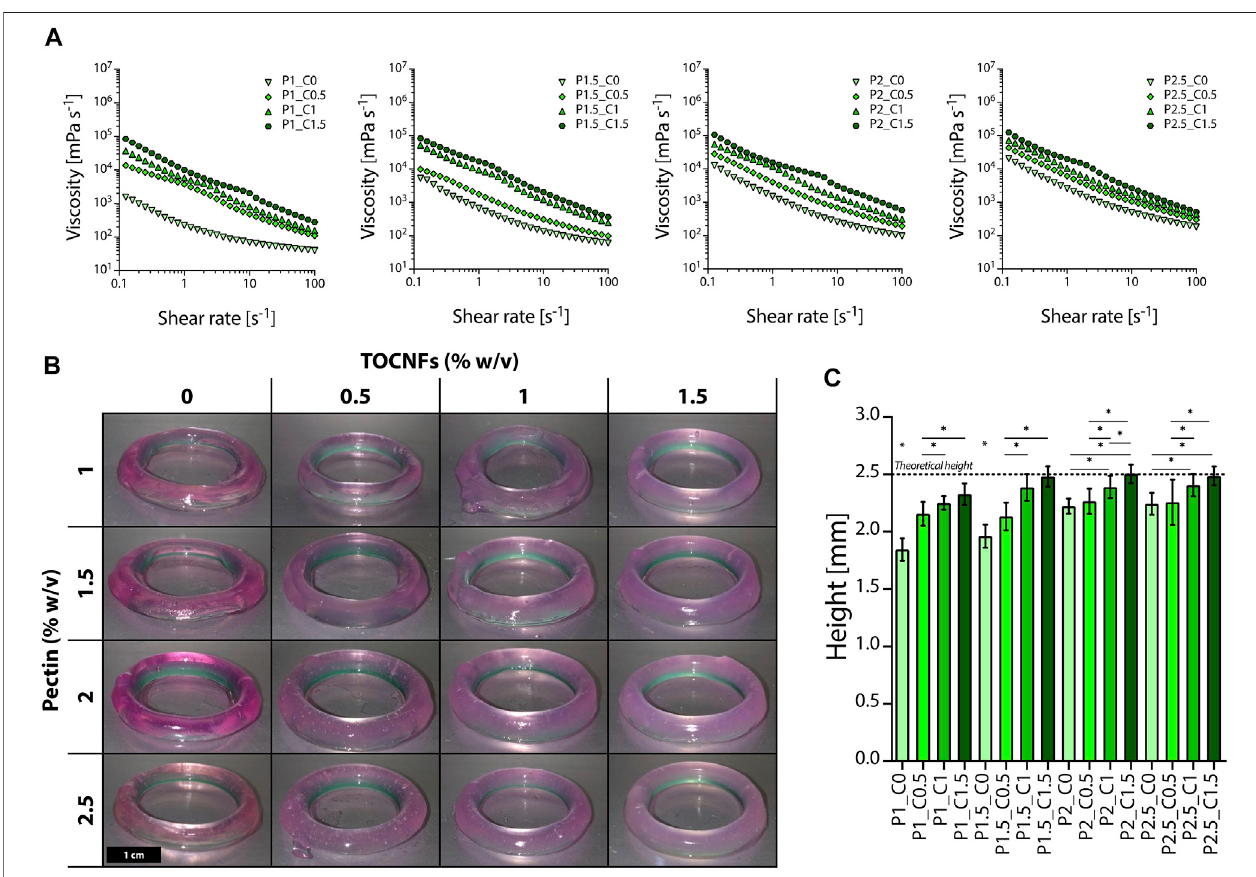
FIGURE 1 | Evaluation of the printability of pectin-TOCNFs inks. (A) Shear rate ramp rheological tests on inks prepared by varying the concentration of pectin (P1, P1.5,P2,andP2.5)andTOCNFs(C0,C0.5,C1,andC1.5). (B) Macroscopicimagesofringsprintedbyvaryingthemulticomponentinkscomposition(scalebar (cid:1) 1 cm). (C) Comparison between the measured height of the printed rings and the theoretical height (dot line); * p < 0.05.